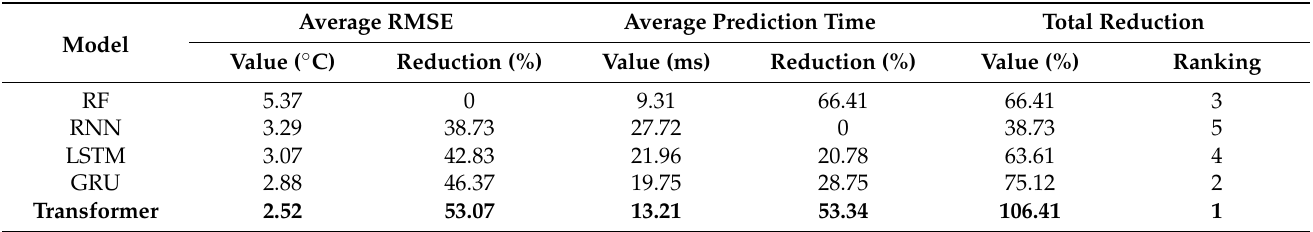
Table 3. Performance when using different time-series prediction